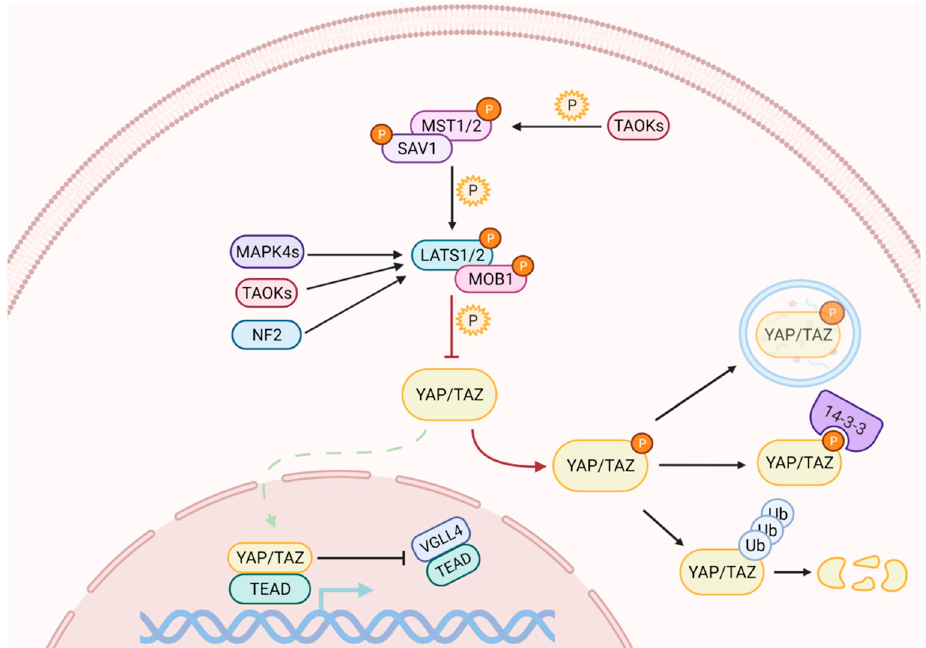
Figure 1. The Hippo signaling pathway comprises a cascade of phosphorylation and activation of kinases, which ultimately regulate YAP and TAZ subcellular localization. When the pathway is on, the activation of LATS1/2 triggers the inhibitory phosphorylation of YAP and TAZ. Phosphorylation on different residues may cause their cytoplasmic retention and/or their degradation through the ubiquitin-proteasome pathway. YAP can also be degraded by autophagy. When the pathway is off, YAP/TAZ dephosphorylation allows their nuclear import, where they compete with VGLL4 for binding to TEAD transcription factors to induce the expression of target genes. See the text for abbreviations.